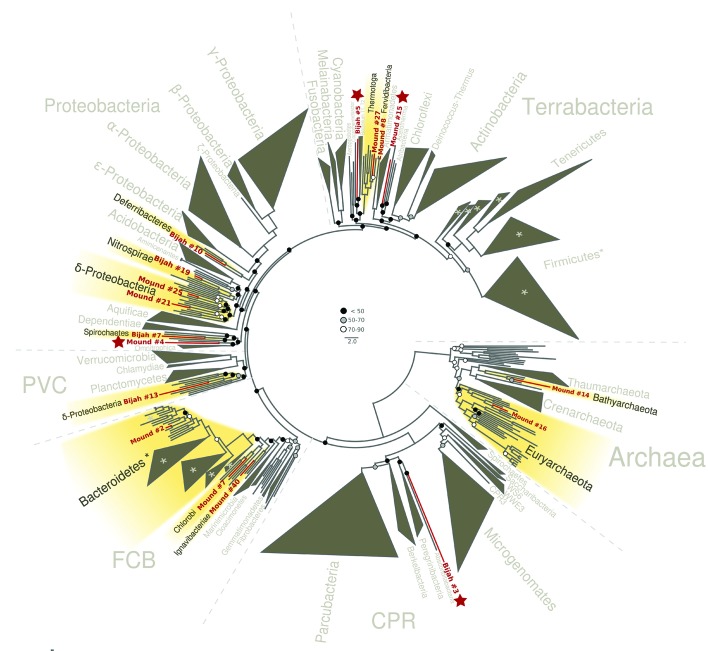
Phylogenetic distribution of selected Yellowstone hot spring genomes (red branches) across a representative set of bacterial and archaeal lineages.Query genomes which potentially represent novel phyla are marked with a star, and those falling into known phyla are highlighted in yellow. Bootstrap support values are displayed at the nodes as filled circles in the following categories: no support (black; <50), weak support (grey; 50–70), moderate support (white; 70–90), while absence of circles indicates strong support (>90 bootstrap support). For details on taxon sampling and tree inference, see Materials and methods.